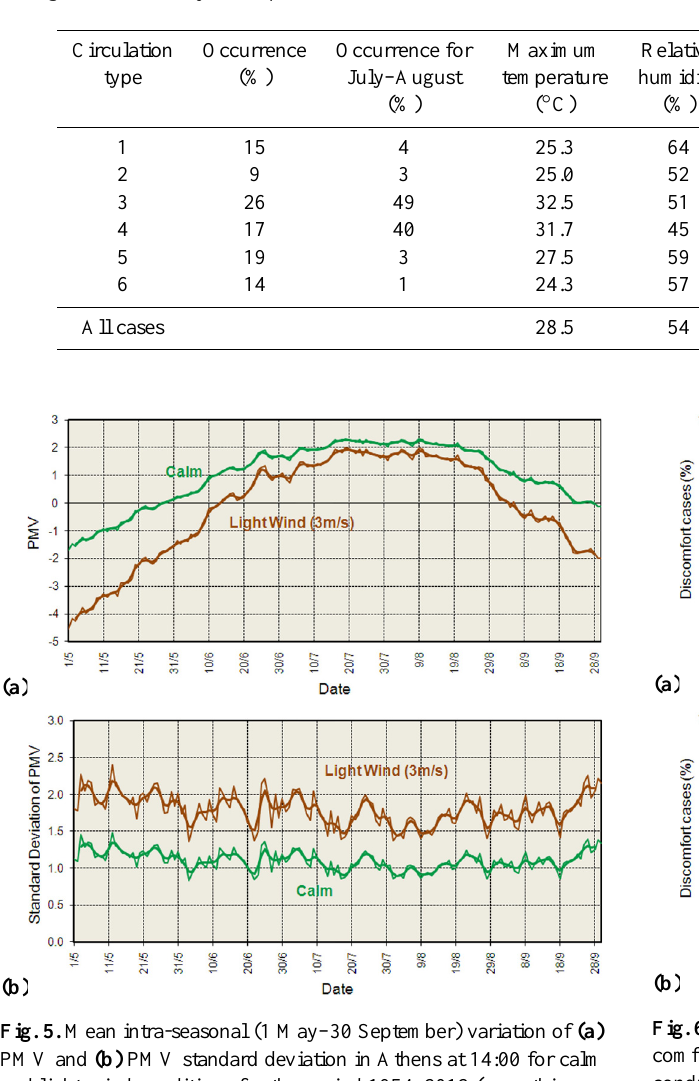
Table 1. Occurrence frequency of circulation types, maximum air temperature, daily relative humidity and 14:00 PMV values in Athens during summer (1 May–30 September).